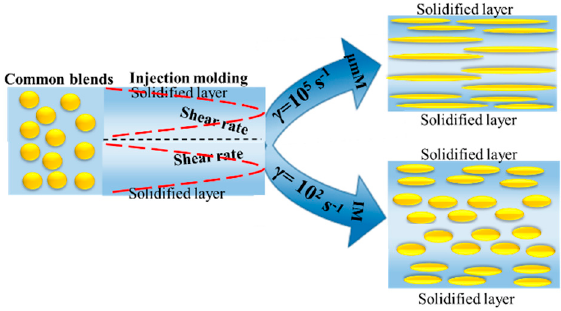
/ PET blends in µ IM and Figure 5. The mechanism of morphology evolution for iPP/PET blends in μ IM and IM. Figure 5. The mechanism of morphology evolution for iPP Figure 5. The mechanism of morphology evolution for iPP/PET blends in μ IM and IM. Figure 5. The mechanism of morphology evolution for iPP/PET blends in μ IM and IM.